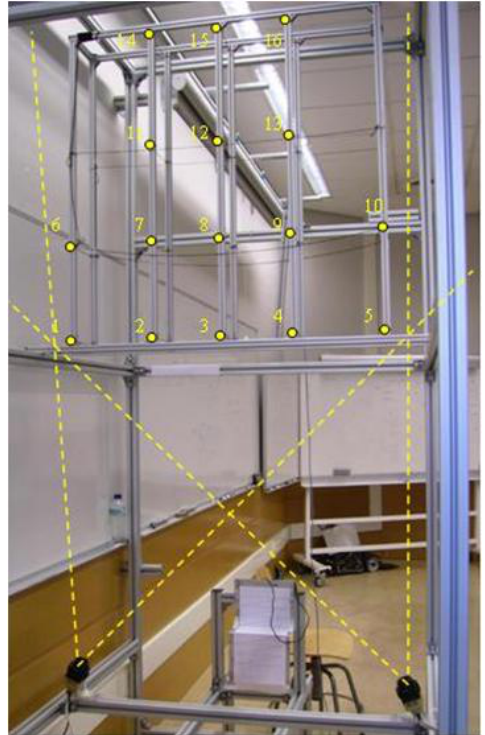
Figure 6. Diagram showing the planes of vision to be crossed by the calibration pattern threads. The distance between the line-scans is 106.5 cm, and the angles α degrees and α = 67.28 LS_R